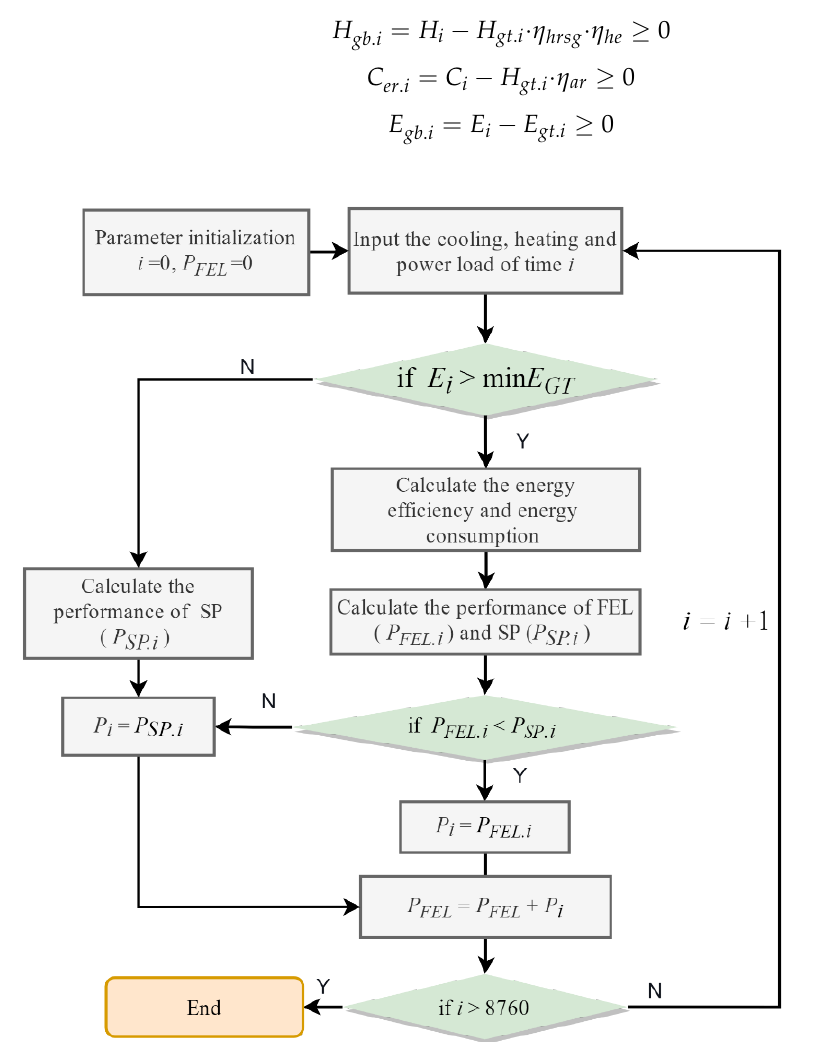
Figure 4. Flowchart of FEL operational strategy.